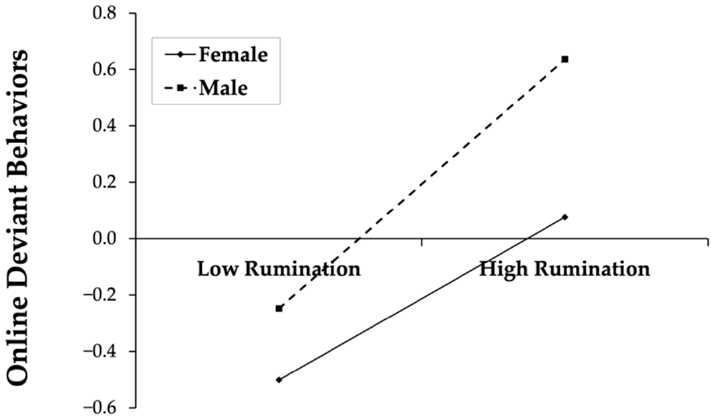
Figure 3. The association between rumination and online deviant behaviors for